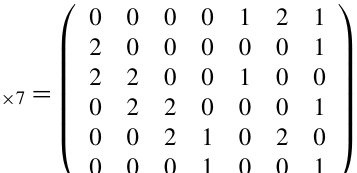
Rotating Pair 7 in the seventh column,